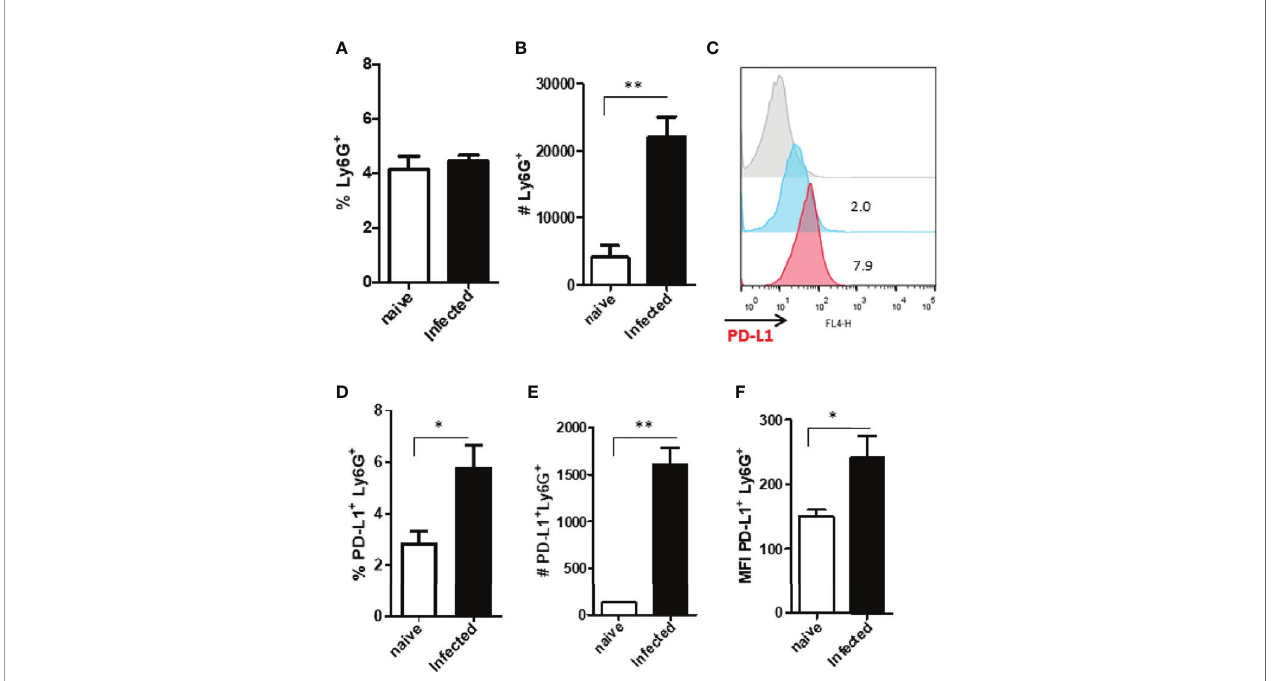
FIGURE 3 | Analysis of murine ear neutrophils after 15 days of infection. Cells were collected from L. amazonensis -infected ears after 15 days then submitted to fl ow cytometry. Controls were performed with uninfected mice (naïve). (A) Percentage of Ly6G + cells. (B) Number of Ly6G + cells. (C) Histogram of PD-L1 expression. Grey = Fluorescence minus one control (FMO) PD-L1 + , Blue = Naïve and Red = Infected. (D) Percentage of PD-L1 + Ly6G + cells. (E) Number of PD-L1 + Ly6G + cells. (F) MFI of PD-L1 + Ly6G + . Data are mean ± SEM from cells of individual mice (N = 4-5/group). *p < 0.03, **p <